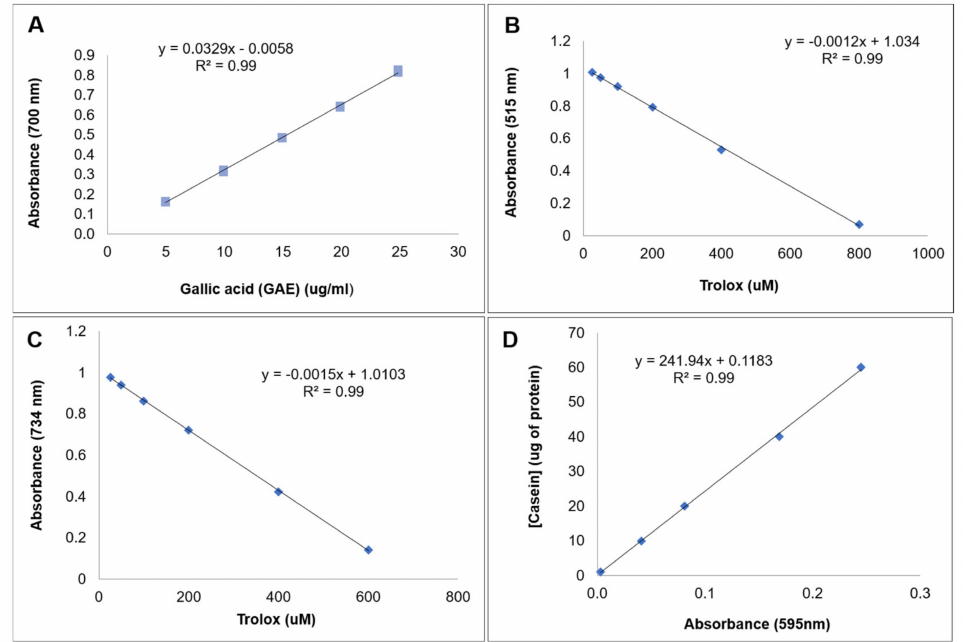
Figure 5. Gallic acid standard curves (GA) for the determination of total phenolic compounds ( A ); Trolox (6-hydroxy-2,5,7,8-tetramethylchromo-2-carboxylic acid) for the determination of DPPH (2.2- diphenyl-1-picryl-hydrazyl) ( B ) and ABTS (2,2 (cid:48) azinobis-[3-ethylbenzthiazoline-6-sulfonic acid]) ( C ); and Casein (CAS: 9000-71-9) by the method of Bradford (1976) for quantification of total proteins ( D